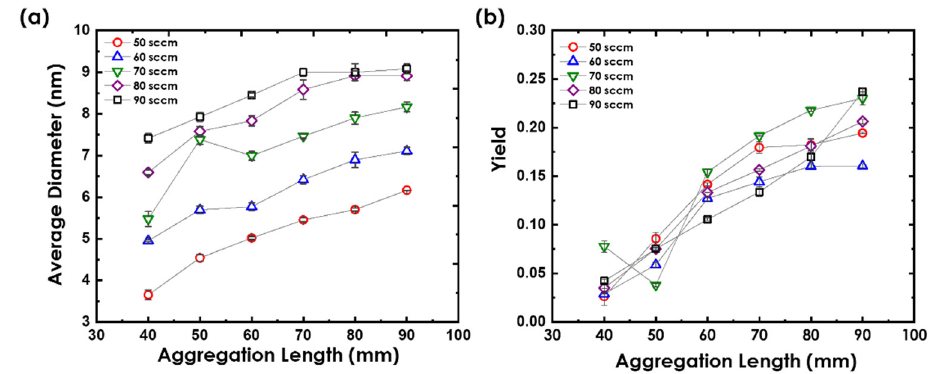
Figure 5. Au nanoclusters’ ( a ) average diameter and ( b ) yield dependence on L shown for various f at P = 12.2 W. at P = 12.2